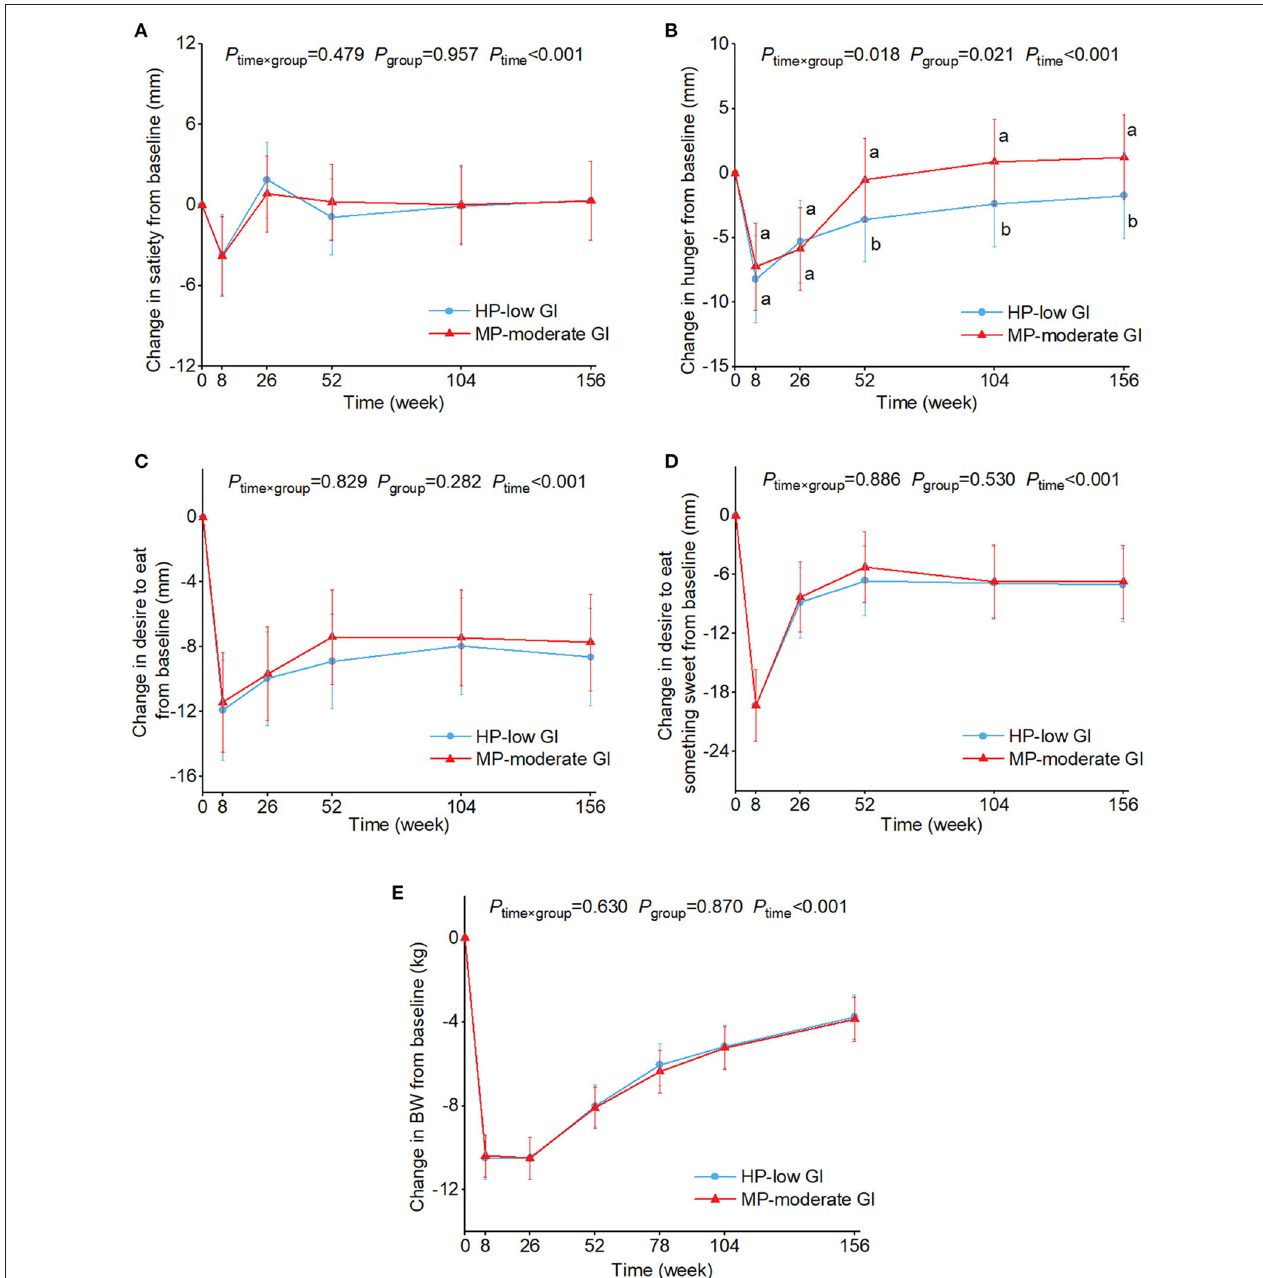
FIGURE 2 | Estimated marginal means and 95% CI in changes in ratings of satiety (A) , hunger (B) , desire to eat (C) , and desire to eat something sweet (D) , and body weight (E) over time by two diet groups. Analyses were performed using a linear mixed model with repeated measures adjusted for age, sex, ethnicity, physical activity groups, baseline appetite ratings (0 weeks), and time as fixed effects and participant-ID and intervention center as random effects. Time × group or group × sex or group × age interaction terms were added. If the interaction was significant, post hoc pair-wise comparisons were conducted at each time point. Values with the different lowercase letters were significantly different, P < 0.05. No group × sex or group × age interaction was observed. BW, body weight; HP-low GI, high protein-low glycemic index diet; MP-moderate GI, moderate protein-moderate glycemic index diet.